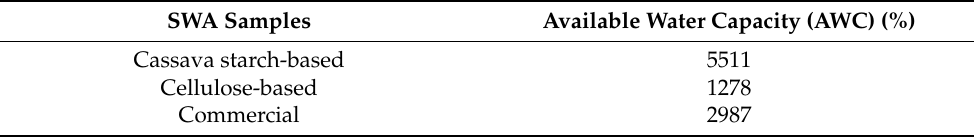
Table 2. Available water capacity (AWC) of three different SWA samples.